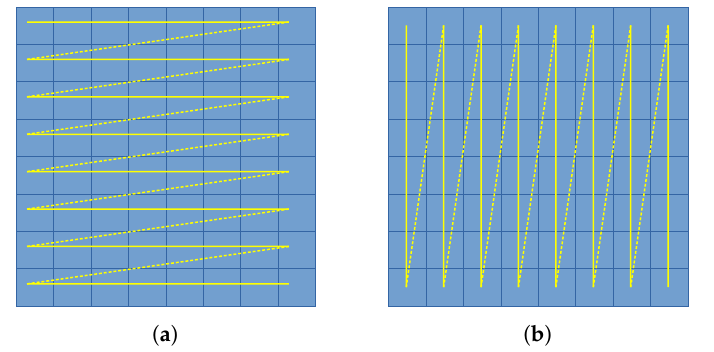
Figure 2. Matrix stored in memory in ( a ) row-major order and ( b ) column-major order.